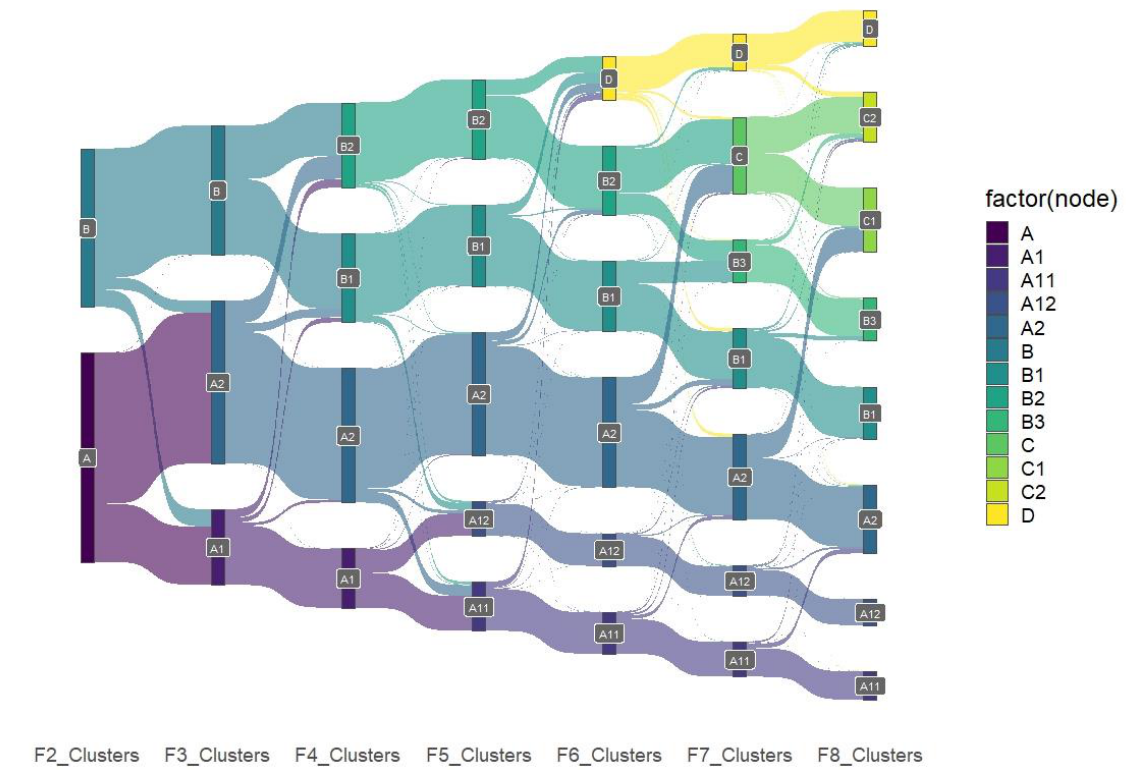
Figure 7. Sankey diagram of the development of clusters of SoLC. The widths of the bands are proportional to number of elements. The diagram also shows transfer of individual catchments and regrouping together with the growing number of clusters. The basic subdivision is already evident when two main groups (A, B) are formed. The groups generated up to five clusters, which are subdivisions of A or B. Group D, which is a combination of previously formed groups, is generated in the six clusters step. Group C arises when the number of clusters reaches seven and eight as combinations of Groups A2 and